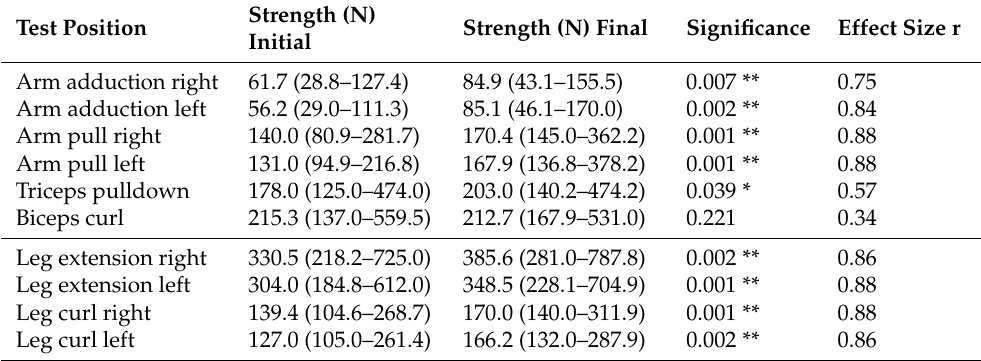
Table 3. Initial and final median maximum strength values (ranges) of the lower body group (LBG).